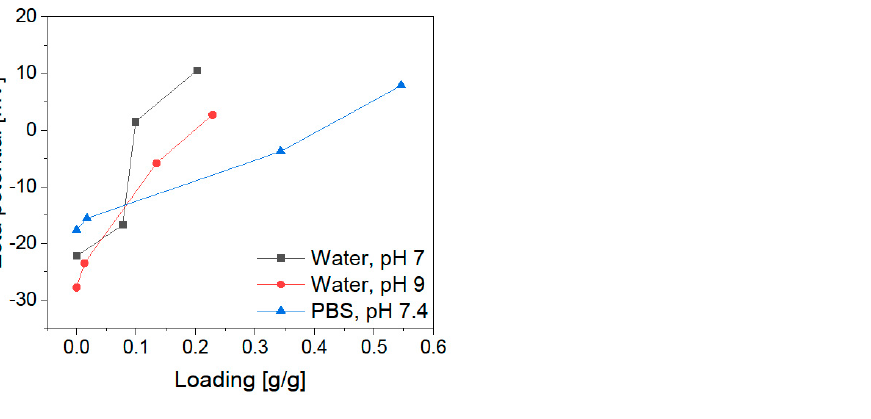
Figure 5. Zeta potential after adsorption of LL to 1 g/L of BIONs at different loadings under the three different conditions.